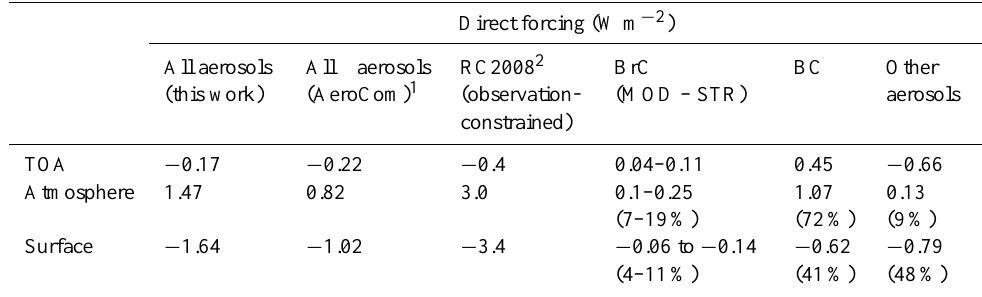
Table 5. Global and annual mean aerosol (fossil fuel, biofuel, and biomass burning) direct forcing for year 2000. Numbers in parentheses indicate the percent of the total aerosol